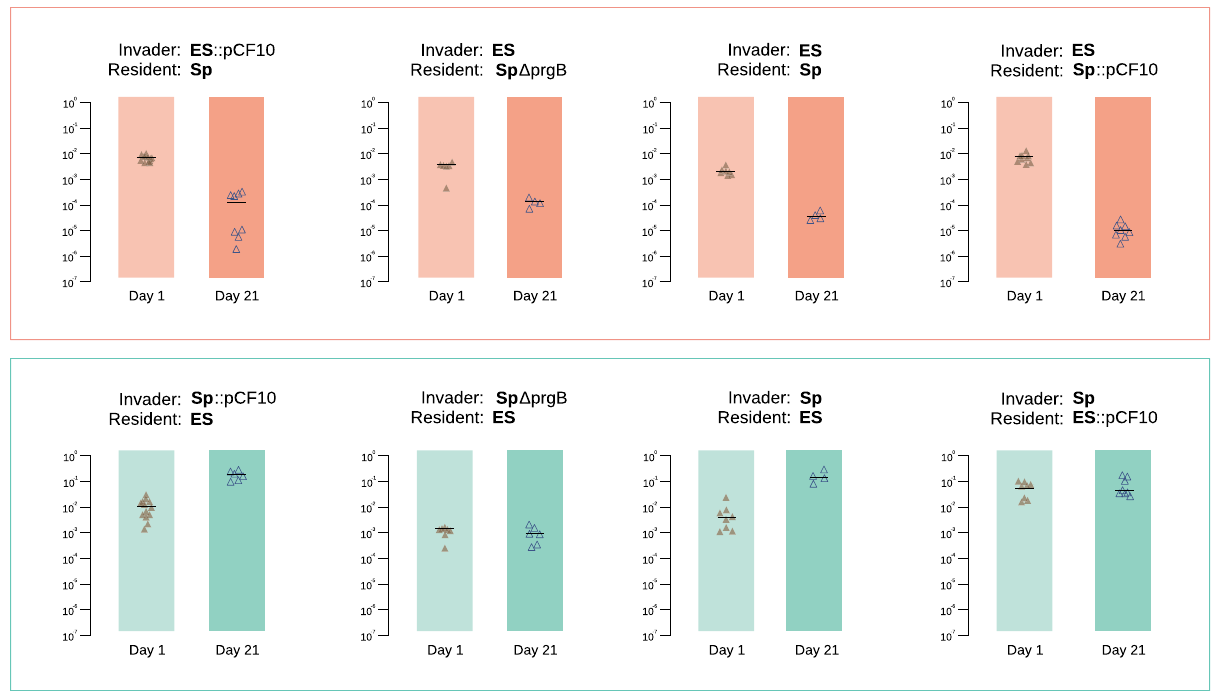
Fig. 3 Success as an invader is dependent on strain background, pCF10, and PrgB. The invasion index (II) is de fi ned as the cell number of the invading strain divided by the cell number of the resident strain in feces (the same primary data used to generate Figs. 1 and 2), at either day 1 or Day 21. Statistical analysis was performed by ANOVA, followed by tests for normal distribution and Mann – Whitney ranked test two-tailed for pair-wise comparison. P values for the population differences between the time points are as follows (invader/resident): ES:pCF10/Sp- <0.001, ES/Sp Δ prgB- 0.001, ES/Sp- 0.004, ES/Sp:pCF10- <0.001,